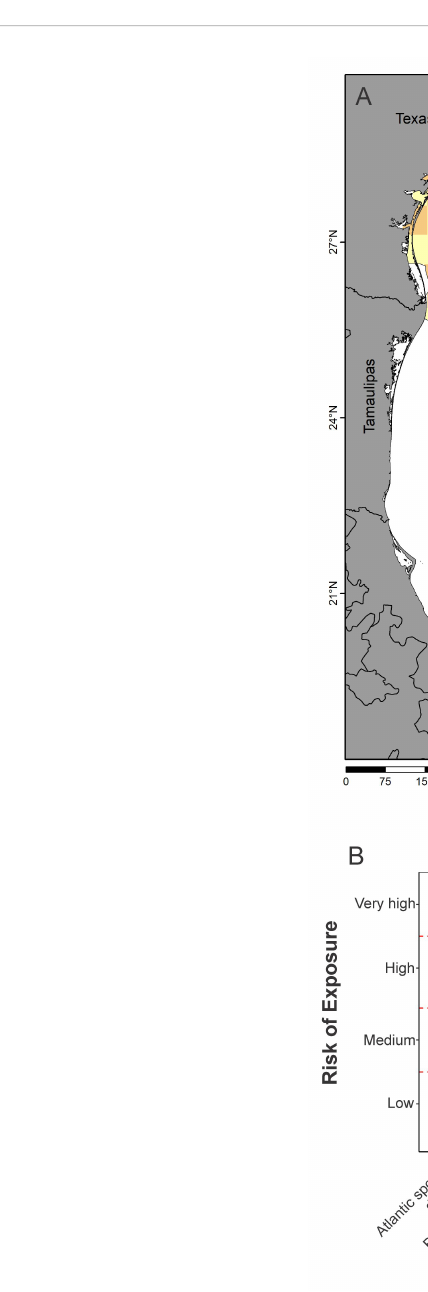
FIGURE 4 (A) Spill scenario for the Perdido well (black asterisk), northwestern Gulf of Mexico. The amount of oil is ranked as low, medium, and high using quantile breaks of the maximum average mass fraction ( P max ). Based on Pe ́ rez-Brunius et al. (2020). (B) Risk of oil exposure of eight species of